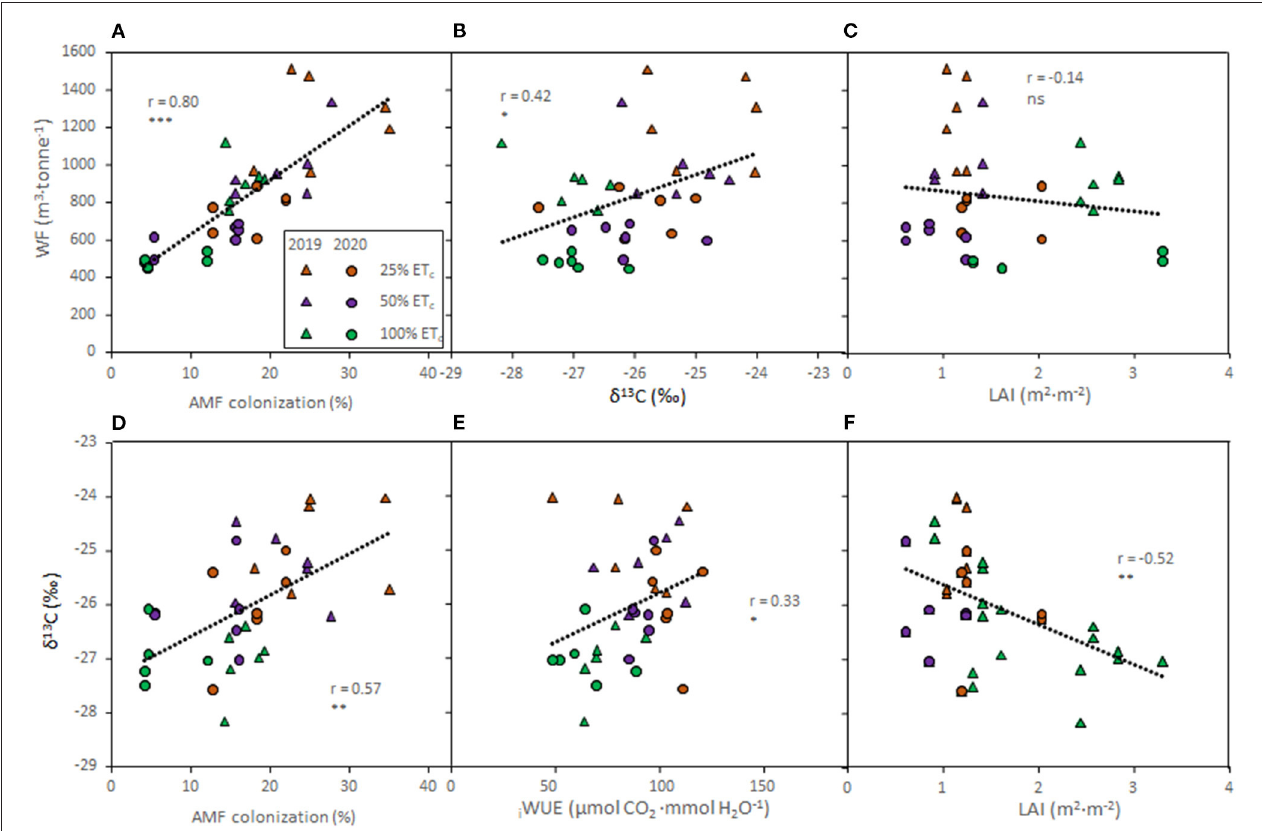
FIGURE 6 | Relationships between total water footprint (WF) and arbuscular mycorrhizal fungi (AMF) colonization rates (A) ; WF and δ 13 C of berry must (B) ; and WF and leaf area index (LAI, C ); δ 13 C of berry must and AMF (D) ; δ 13 C and intrinsic water use efficiency ( i WUE, E ); and δ 13 C and LAI (F) of Cabernet Sauvignon grapevines (clone FPS08) subjected to different replacement of crop evapotranspiration (25, 50, and 100% ET c ), collected in Oakville, CA, in 2018–2019 (triangles) and 2019–2020 (circles) growing seasons. For each combination, straight lines correspond to the linear regression lines fitted for the pooled data of all treatments in both seasons. ns, *, **, and *** indicate non-significance and significance at 5, 1, and 0.1% probability levels,